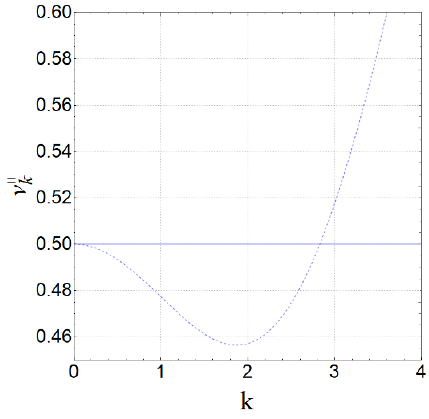
. Note that below (cid:23) k = 1 = 2 spectral weight k k